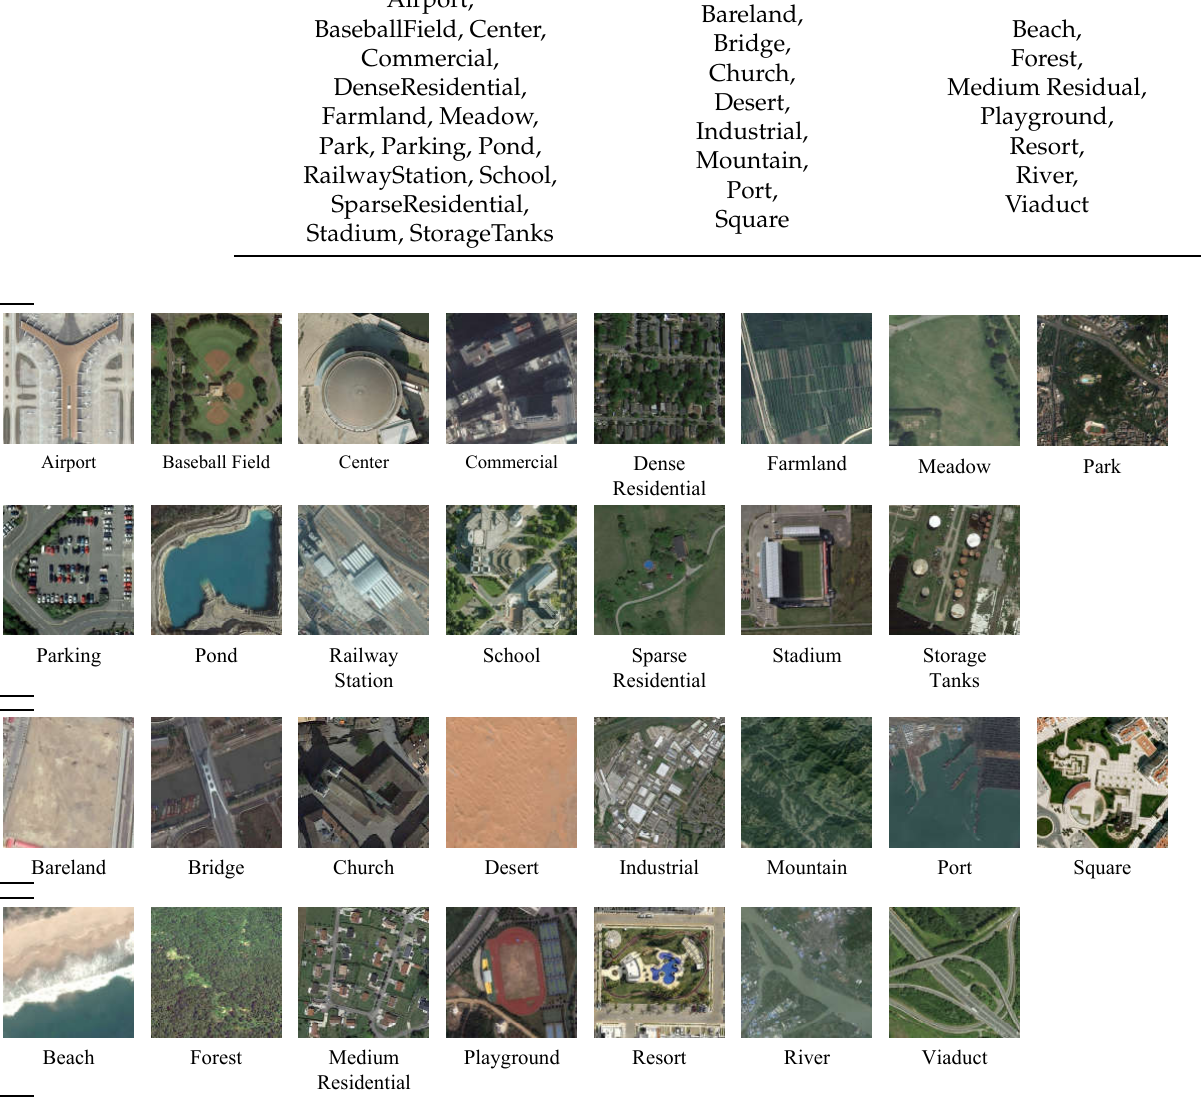
Figure 8. The train, validation, and test partitions of dataset